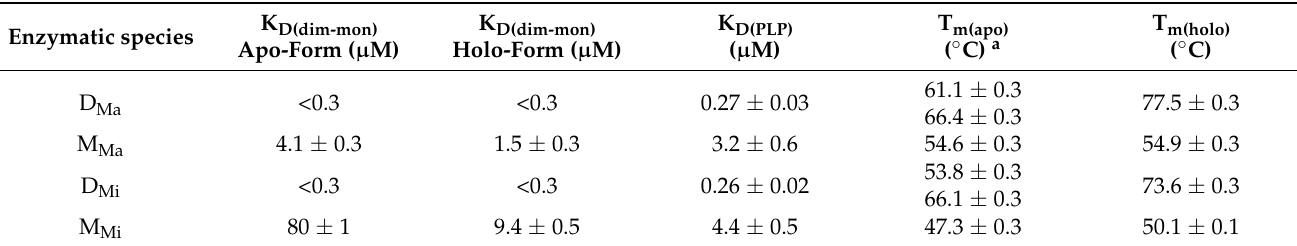
Table 1. Parameters for quaternary structure, pyridoxal 5 (cid:48) -phosphate (PLP) binding and thermal denaturation of ala- nine:glyoxylate aminotransferase (AGT) enzymes. Experiments were performed in KP 0.1 M, pH 7.4. Values of K D(PLP) and T m of M Ma and M Mi were determined at a protein concentration in which the monomeric form was >90%. Tm values were obtained by monitoring the loss of circular dichroism (CD) signal at 222 nm. Data on the holo-forms were determined in the presence of saturating